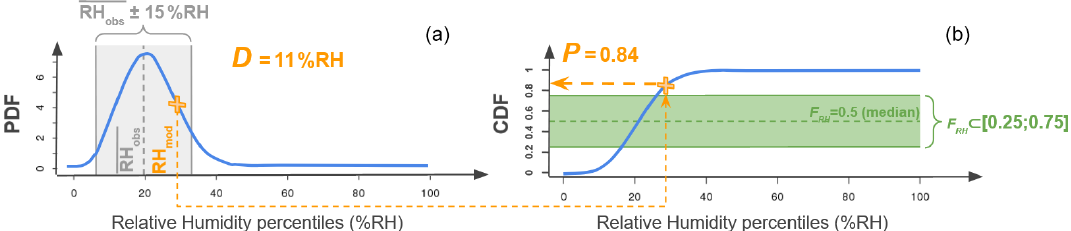
Figure 2. Single-grid-box example (grid point situated 24.75 to 25 ◦ N, 114.5 to 114.75 ◦ W, and 400–600hPa for the simulations of 1 April 2018 at 00:00UTC) showing the projection of RH mod (orange cross) onto its associated reference distribution RH obs (blue curve) in terms of PDF (a) and CDF (noted F RH ; b ). The reference expectation (first moment of the distribution) noted RH obs is drawn as the gray dotted line centered within a ± 15%RH range (gray shade) on the PDF. The expected value (median) of the distribution is shown as the dotted green line on the CDF, and the 0.25–0.75 quantile interval is shaded in